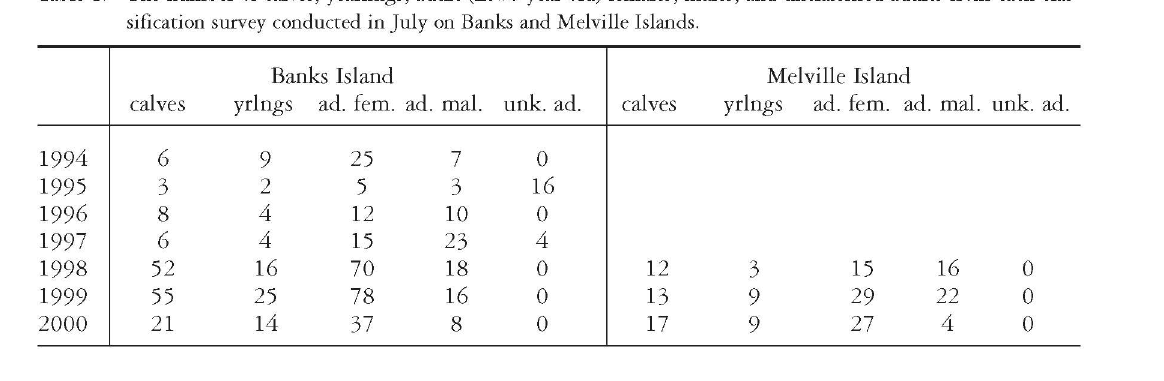
Table 1. The number of calves, yearlings, adult (>two-year-old) females, males, and unclassified adults from each clas sification survey conducted in July on Banks and Melville Islands. Banks Island calves yrlngs ad. fem. ad. mal. unk. ad. calves